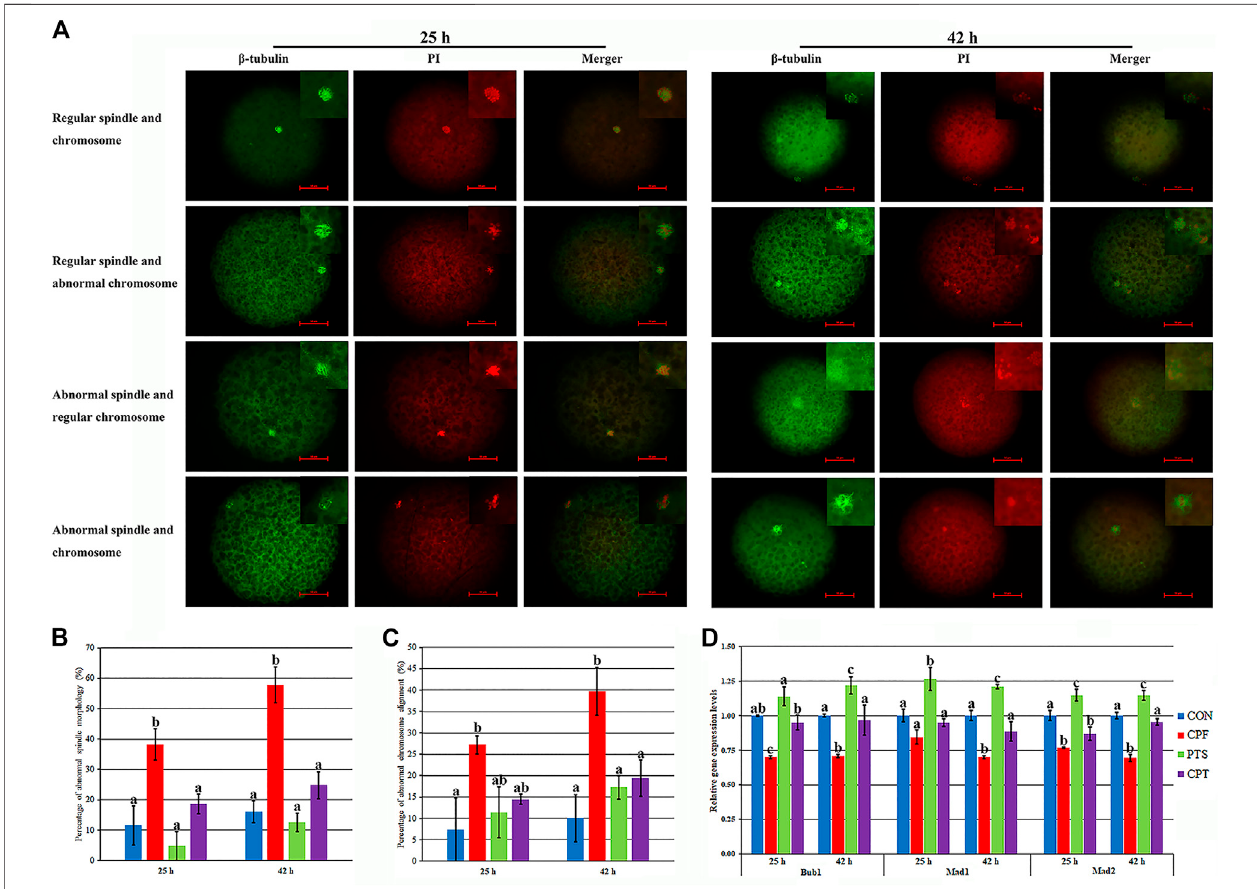
FIGURE 3 | Effect of CPF and PTS on oocyte spindle assembly and chromosome alignment. (A) , spindle or chromosome morphology ( × 400). (B) , percentage of abnormal spindle morphology. (C) , percentage of abnormal chromosome alignment. (D) , relative expression of SAC related genes. The number of oocytes for spindle and chromosome detection intheCON,CPF,PTSorCPT groupwas23,30,19or21at25 h,or45,34,47or39at42 h,respectively. a-c Valuesforacertain groupwith different superscripts differ signi fi cantly ( p < 0.05).